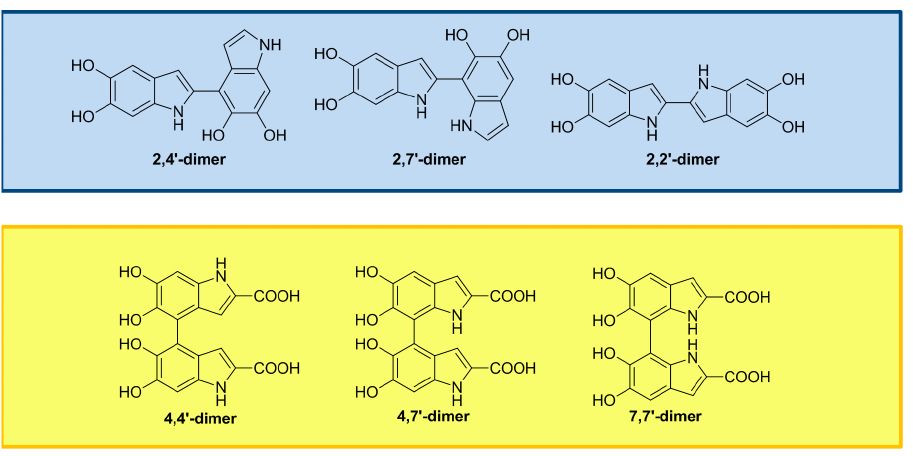
Figure 1. Main oxidation products of DHI (blue box) and DHICA (yellow box).